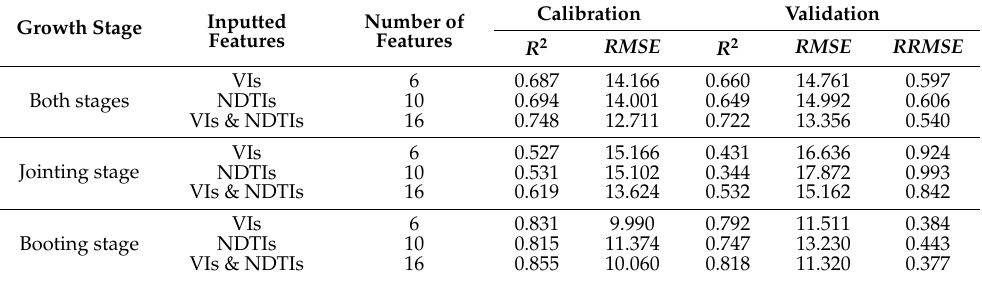
Table 5. Results of partial least-squares regression (PLSR) models based on different inputted features.